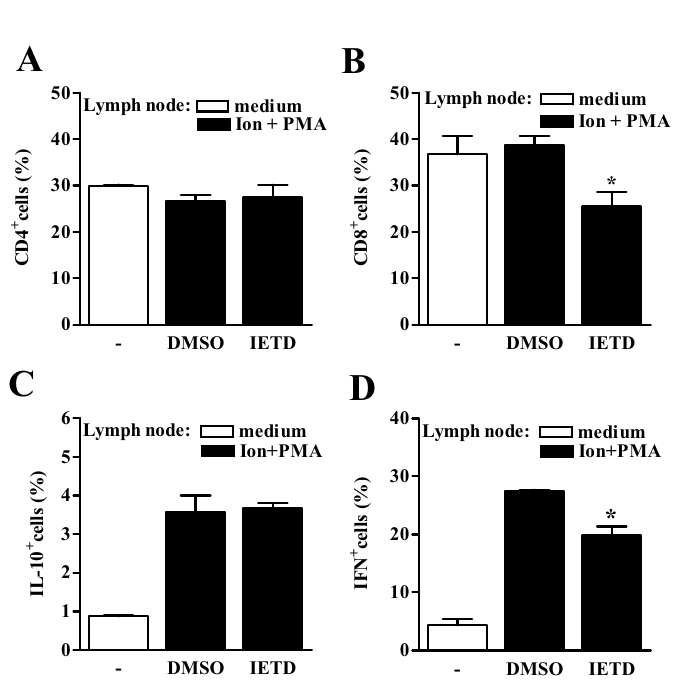
Fig. 4 – Expression of type 1 and type 2 cytokines in L. major infection. Lymph node cells from infected (2 wk) mice were stimulated with anti-CD3 only or in the presence of zIETD or stock diluentDMSOfor72h. Cellswerere-stimulatedwithPMAandionomycinfor4h, inthepresence of brefeldin A. Cells were stained with anti-CD4 (A), anti-CD8 (B) or permeabilized and stained with anti-IL-10 (C) and anti-IFN- γ (D). Results are expressed as average and SEM. Significant differences between cells treated with zIETD and DMSO were indicated for p < 0 . 05 ( ∗ )